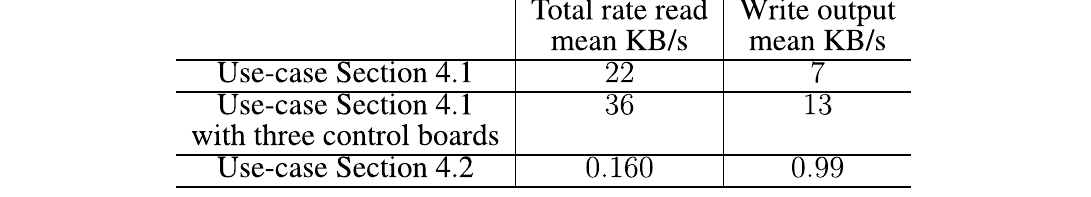
FIGURe 5 | The top image shows the UML class diagram, the middle table shows the computational overload of the generated code, and the bottom table shows the network overload of the generated code . (A) UML class diagram. (B) Computational overload. The results show the additional execution time of reading the inputs and writing the output Bottle. (C) Network